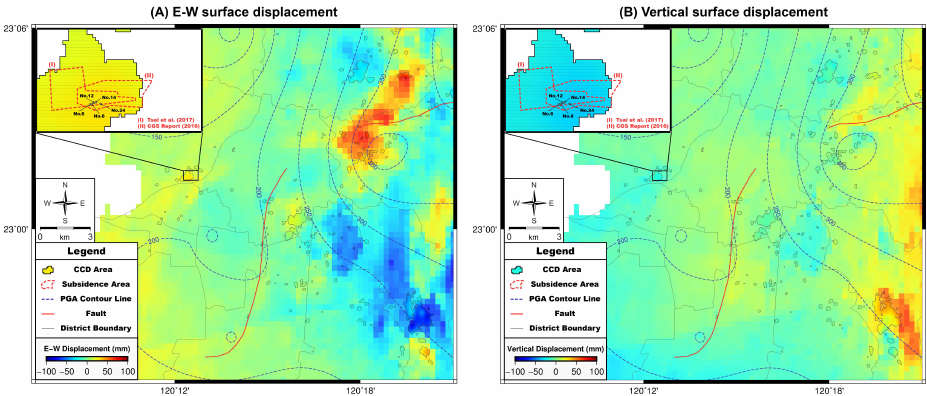
Figure 10. Inversion of 2D surface displacements for the study area: ( A ) The distribution of east-west directional surface displacement, where the warm color represents eastward movement and the cold color represents westward movement. ( B ) The distribution of vertical surface displacement in the study area, where the warm color shows the upward movement and the cold color shows the downward movement. Red dashed lines in the enlarged figures enclose the local subsidence area. Area (I) was modified from the results in Tsai et al. [9], and Area (II) was modified from the Central Geological Survey (CGS) field surveys